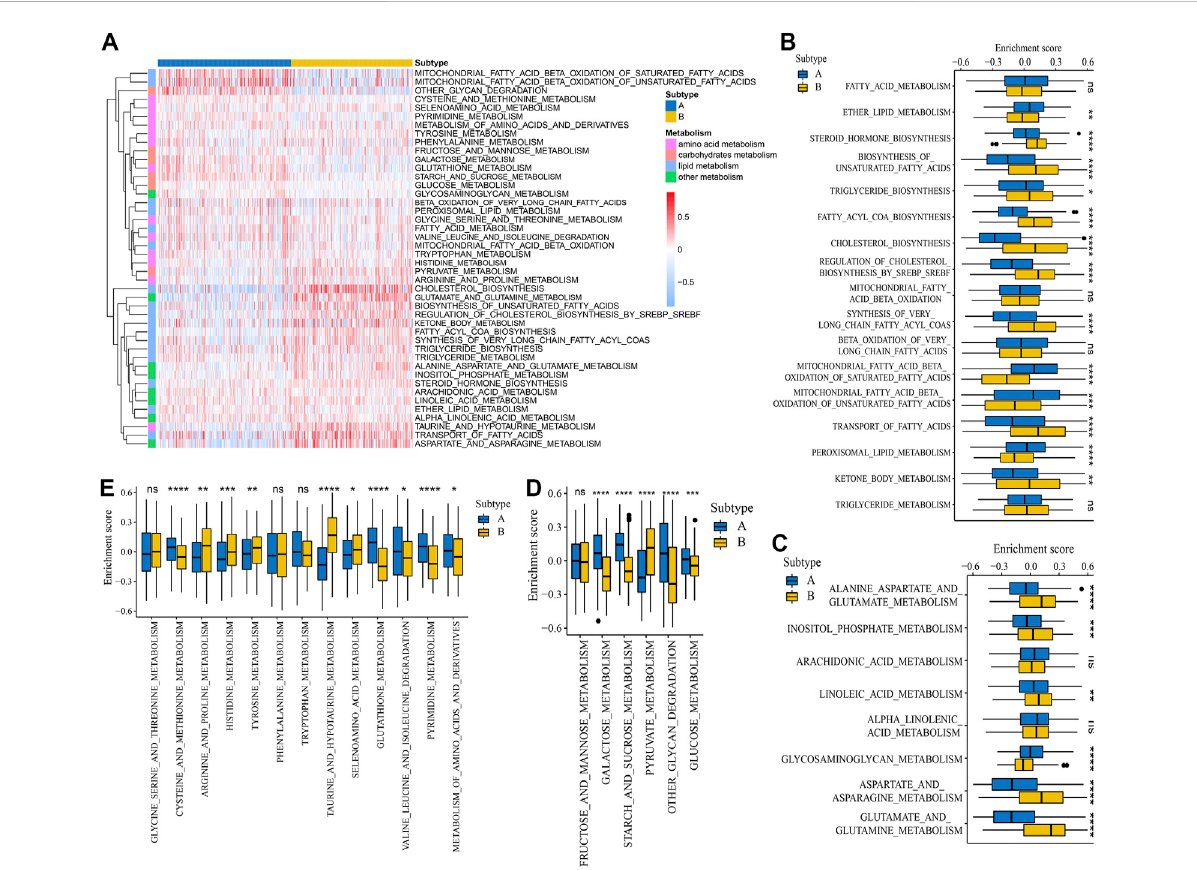
FIGURE 2 Metabolism features of the glycosylation subtypes. (A) Heat map depicted the activation states of metabolism-associated process between subtypes based on GSVA enrichment scores. Red represents activated processes and blue represents inhibited processes. Differences of GSVA enrichment scores of the metabolism-associated process including lipid metabolism (B) , other metabolism (C) , carbohydrates metabolism (D) , and amino acid metabolism (E) between the subtypes. * p < 0.05; ** p < 0.01; *** p < 0.001; **** p < 0.0001; ns, not signi fi